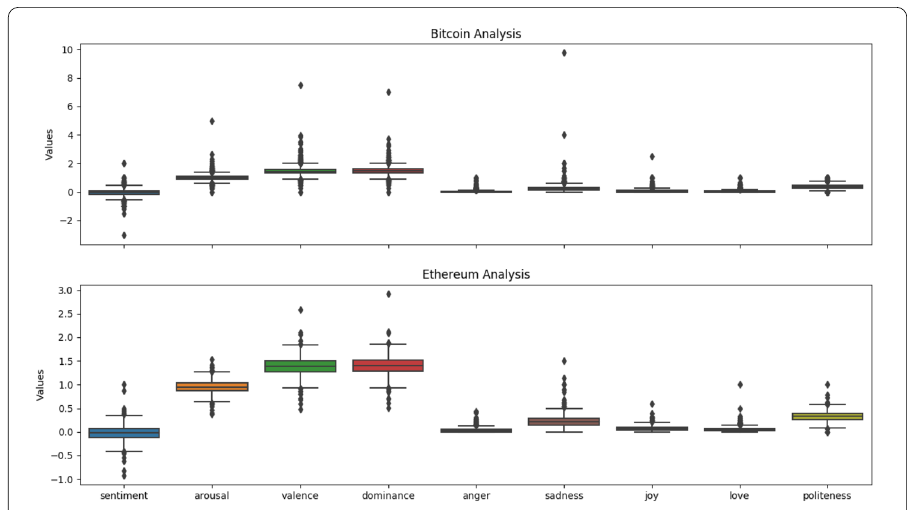
Figure 1 Distributions of the affect time series. Boxplot of the Bitcoin (top panel) and Ethereum (bottom panel) distributions for all affect metrics and all Github